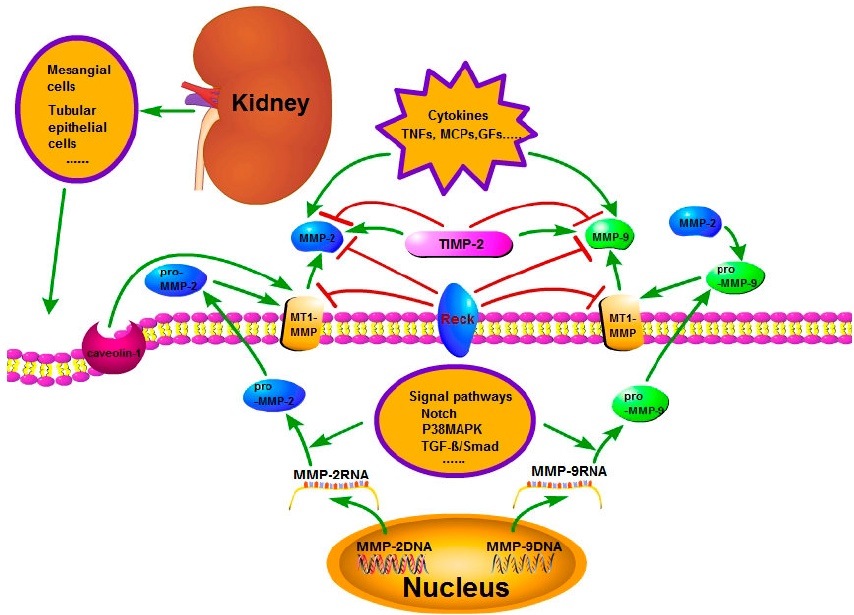
Figure 1. The regulation of activity and expression of matrix metalloproteinase-2 and 9 (MMP-2 and